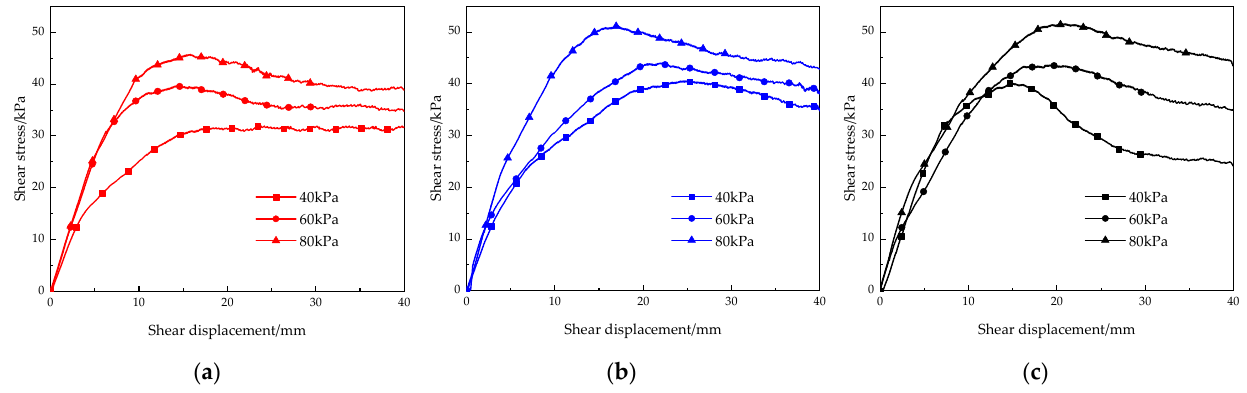
Figure 11. Shear displacement ‒ shear stress curve of the reinforced soil interface under a frozen state ( − 5 °C): ( a ) 2% water content; ( b ) 4.5% water content; ( c ) 7% water content.